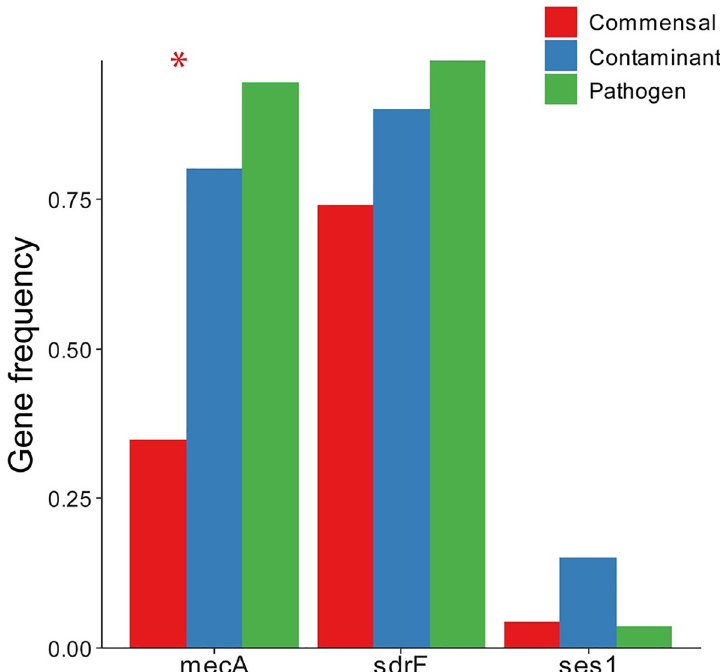
Fig 4. Frequency of virulence genes. � indicates χ 2 p < 0.05 with Bonferroni correction for multiple comparisons.